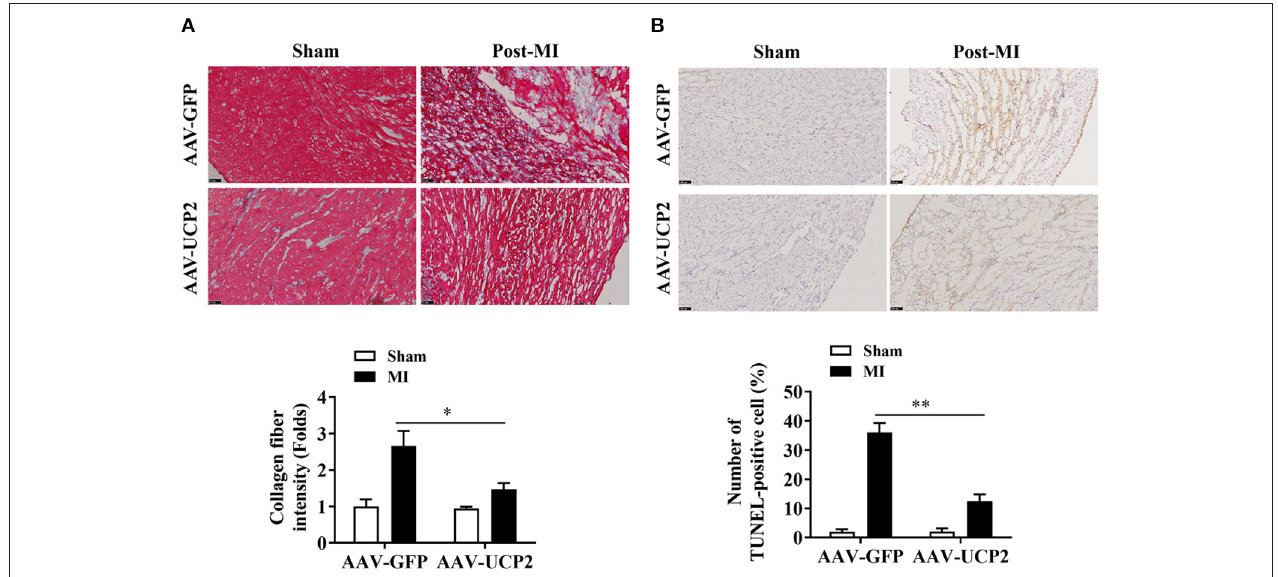
FIGURE 3 | UCP2 overexpression in heart reduce myocardial fibrosis and cardiomyocyte apoptosis 4 weeks after MI. (A) Masson’s trichrome staining of heart tissue sections showing the presence of myocardial fibrosis in the border zones of the infarcted regions 4weeks after MI ( n = 3). (B) TUNEL assay showing the effects of overexpression UCP2 on cardiomyocyte apoptosis 4 weeks after MI ( n = 3). MI, myocardial infarction; * p < 0.05, ** P < 0.01 compared with each other.